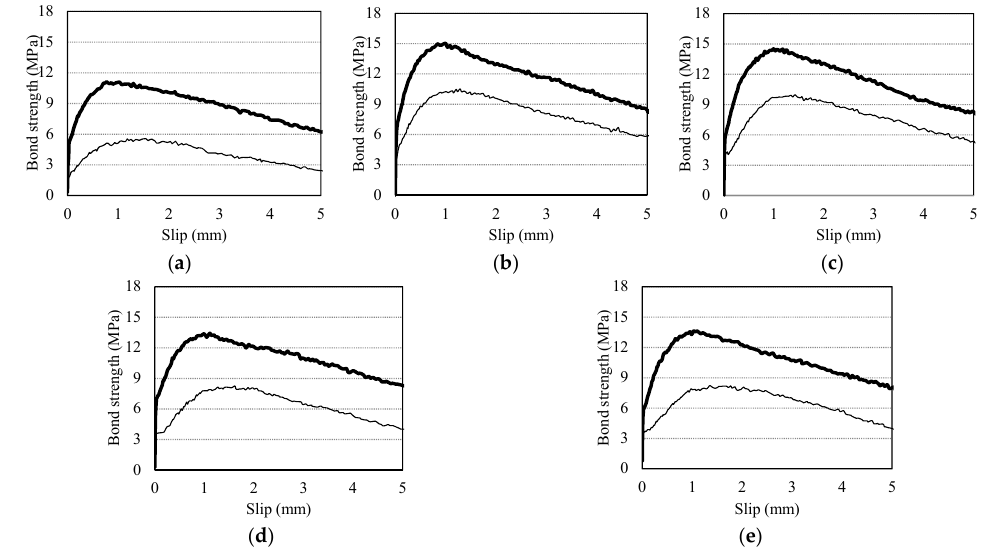
Figure 7. Bond strength-slip curves of two-tiered specimen. ( a ) G0F0H; ( b ) G15F60H; ( c ) G30F45H; ( d ) G45F30H; ( e ) G60F15H.